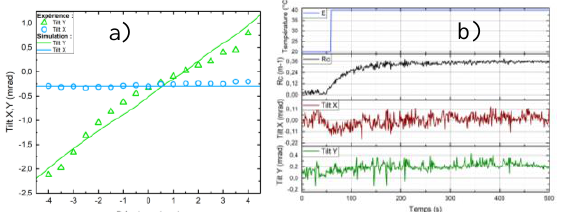
Figure 3. (a) Horizontal (green) and vertical (blue) tilt versus offset vertical offset of the AMA. Points: experimental ; Line: simulations. (b) Evolution of the temperature of AMA (blue), radius of curvature of active-mirror (black), horizontal tilt (wine) and vertical tilt (green) versus time during pumping.